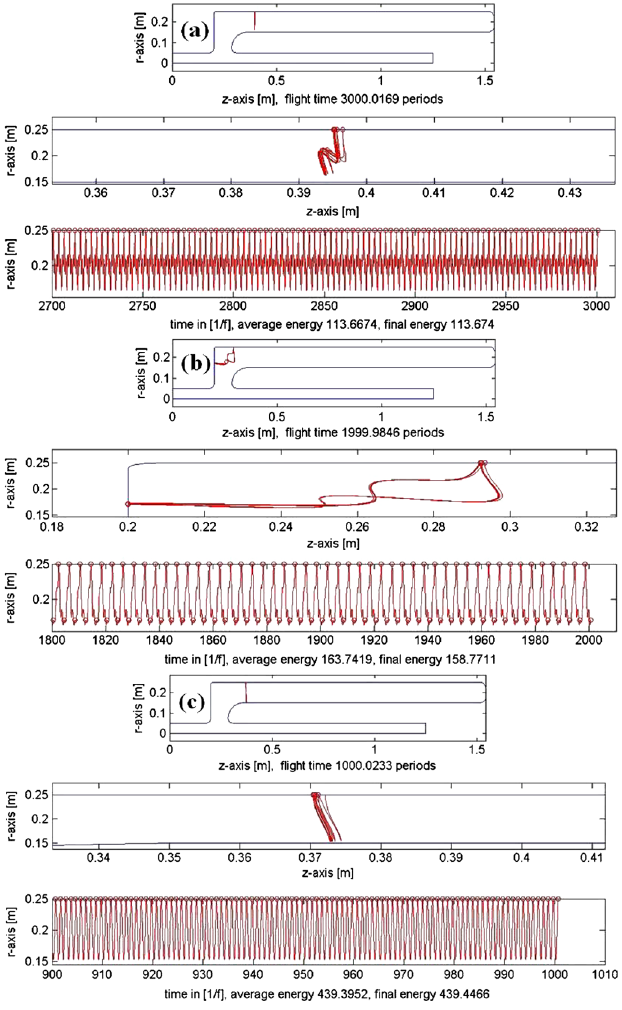
have been shown.